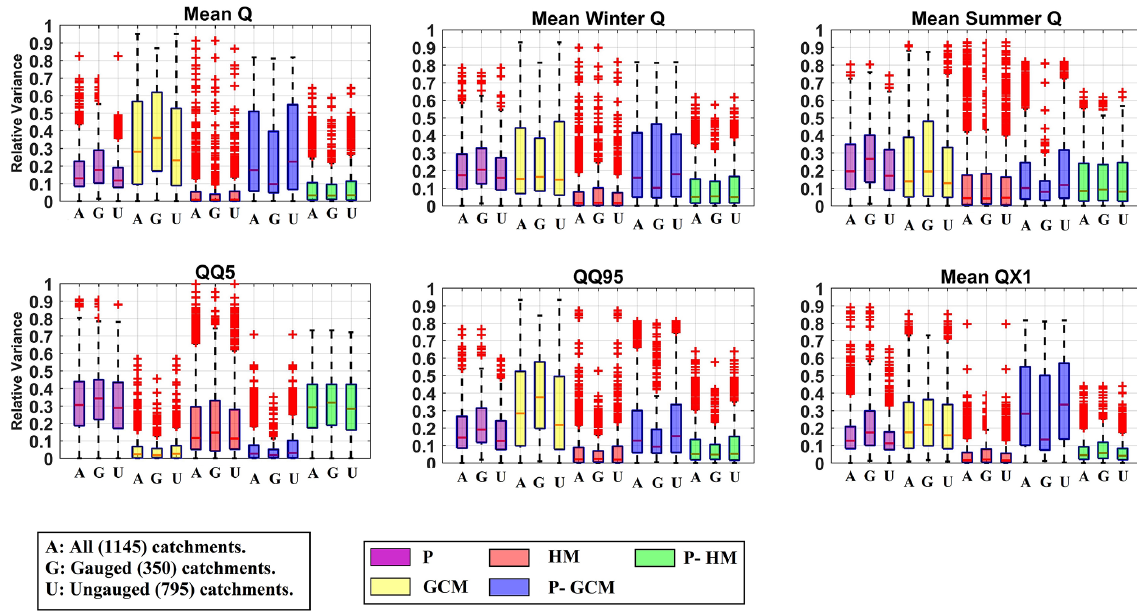
Figure 4. Box plots of the relative variance attribution results for the five main contributors to overall variance (P, GCM, HM, P-GCM and P-HM) and six streamflow metrics. Relative variance is shown for all 1145 catchments (A) and 350 gauged (G) and 795 ungauged (U)